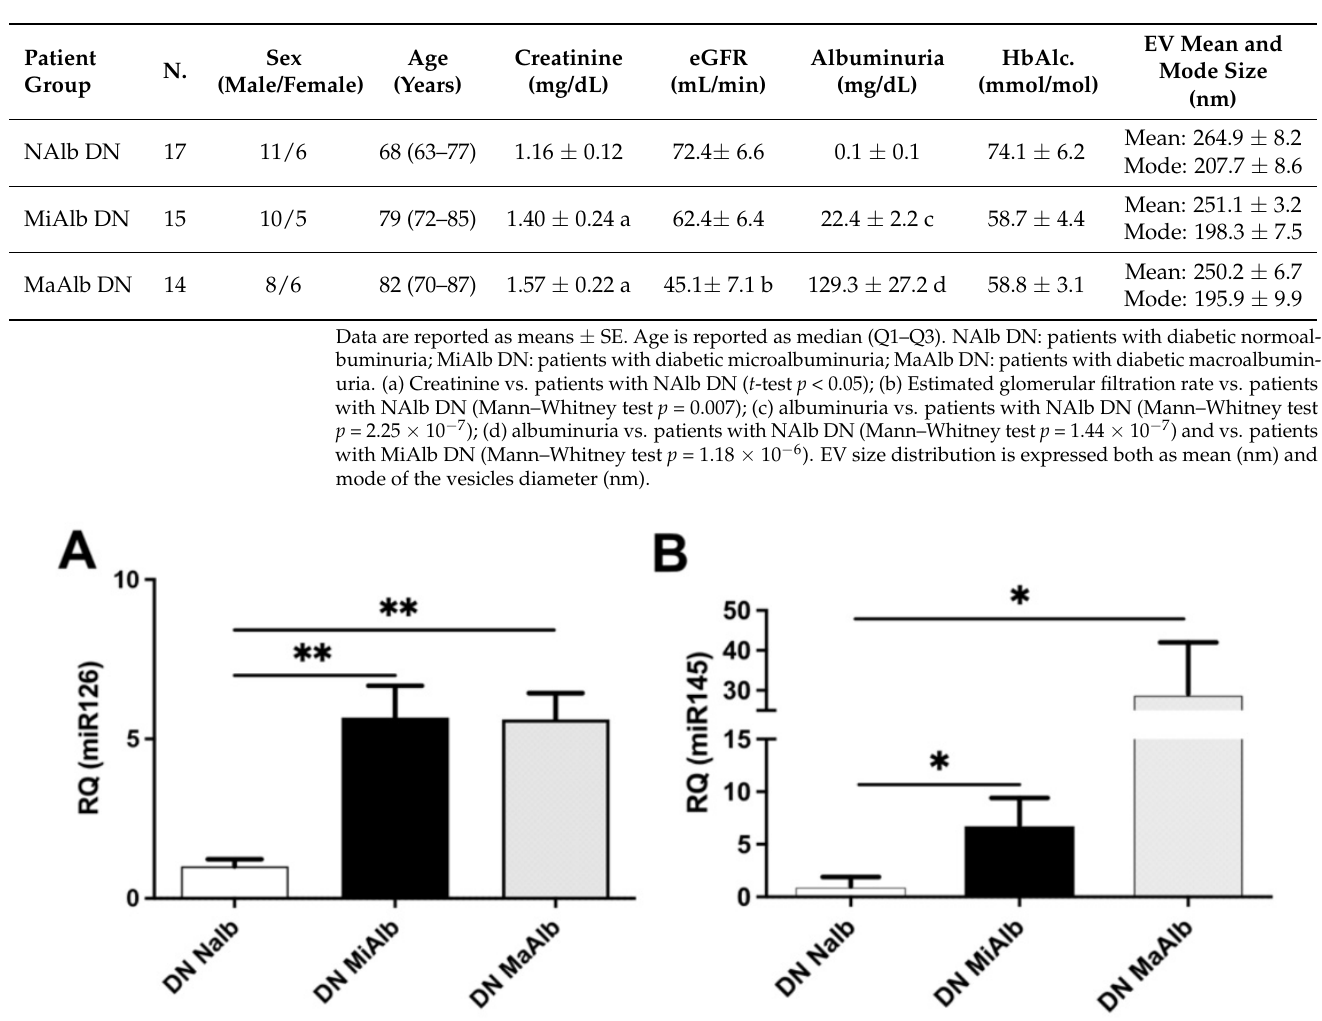
normoalbuminuric (NAlb), microalbuminuric (MiAlb) and macroalbuminuric (MaAlb) patients and